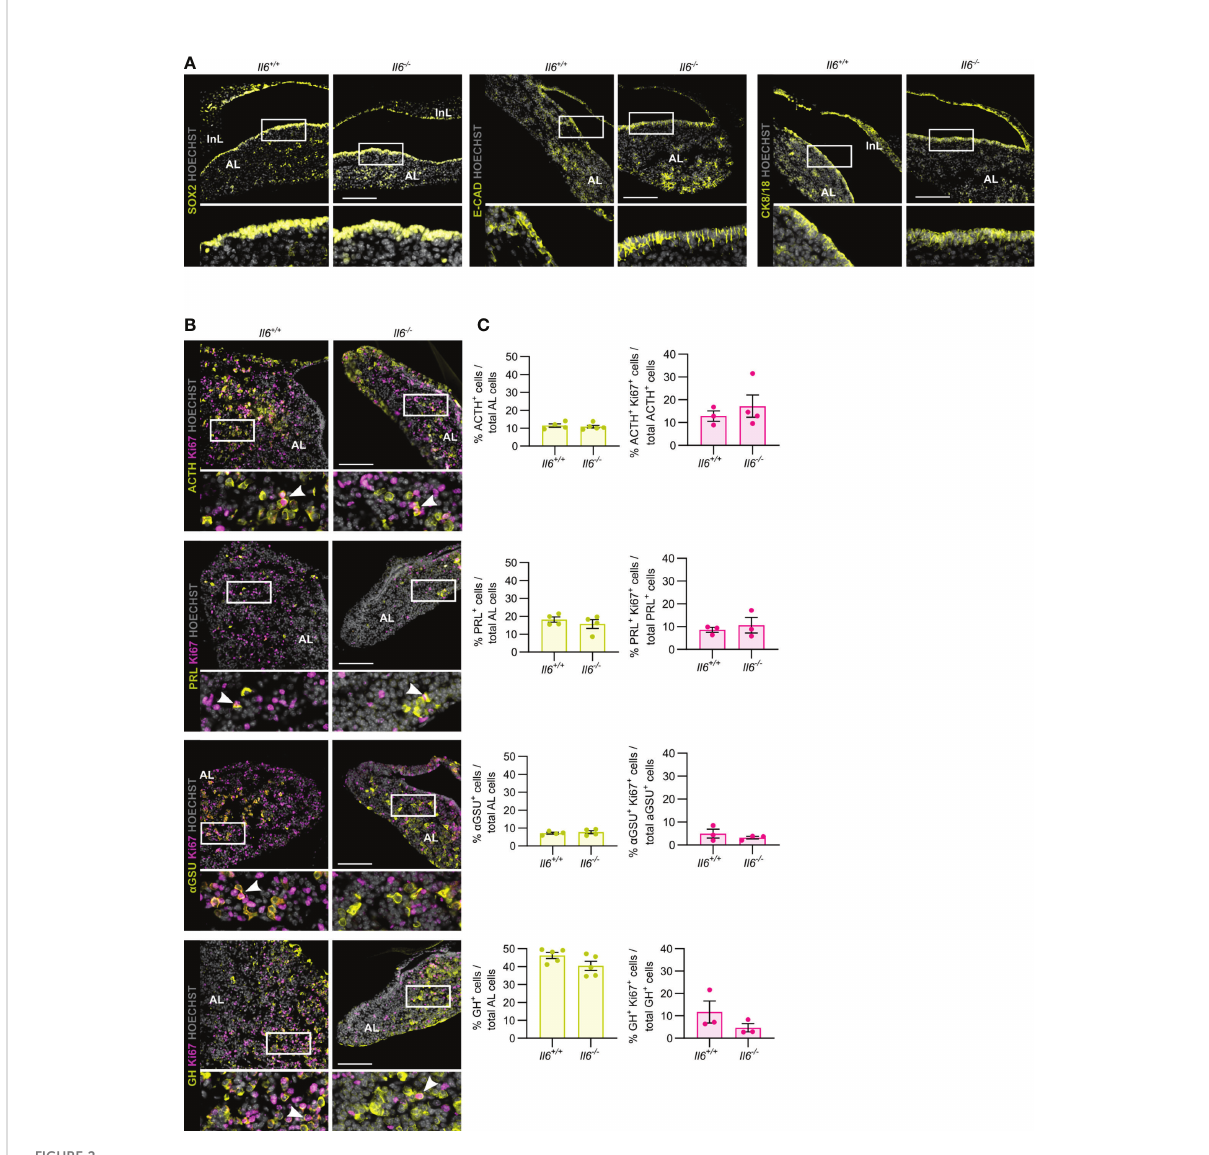
FIGURE 2 Pituitary neonatal phenotype is not affected by absence of IL-6. Immuno fl uorescence analysis of neonatal (PD7) Il6 +/+ and Il6 -/- pituitary for SOX2, E-CAD and CK8/18 (all yellow) (A) and for ACTH, PRL, a GSU and GH (all yellow), together with Ki67 (magenta) (B) . Hoechst33342 was used as nuclear stain (grey). Boxed areas are magni fi ed in the respective bottom panels. Arrowheads indicate selected double-positive cells. Scale bar, 100 m m. Proportion of hormone + cells in total AL cell population (left) or of proliferating (Ki67 + ) hormone + cells in the speci fi c hormone + cell compartment (right). Bars depict mean ± SEM (n = 3-5, all individually shown; unpaired t-test) (C)